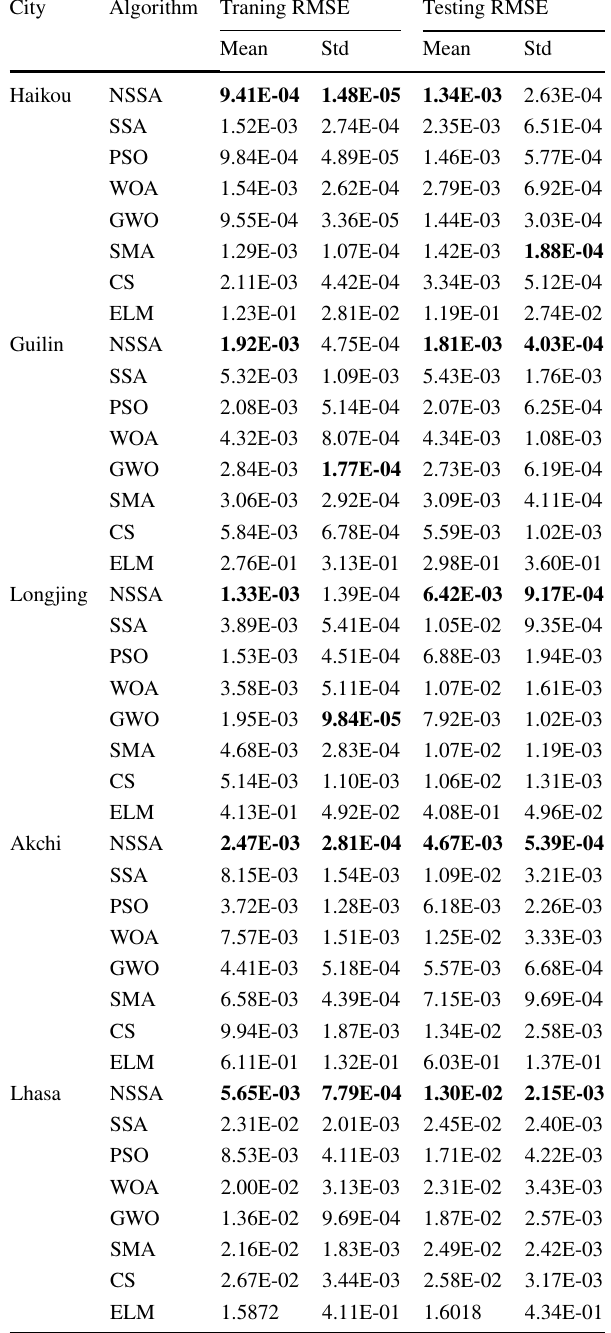
Bold indicates optimal